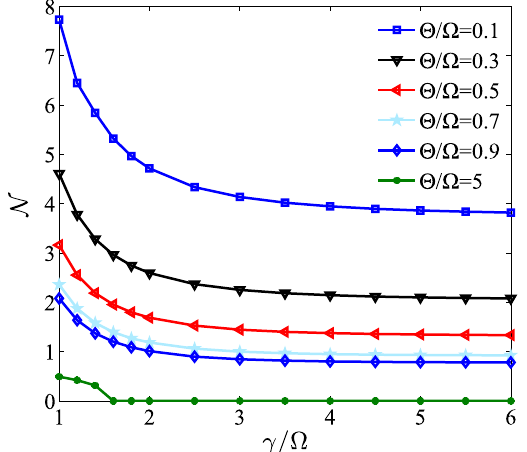
Figure 3. The non-Markovianity,  , as a function of γ Ω / for different values of Θ Ω / . From top to bottom, Θ Ω / takes on values from 0.1 to 5.